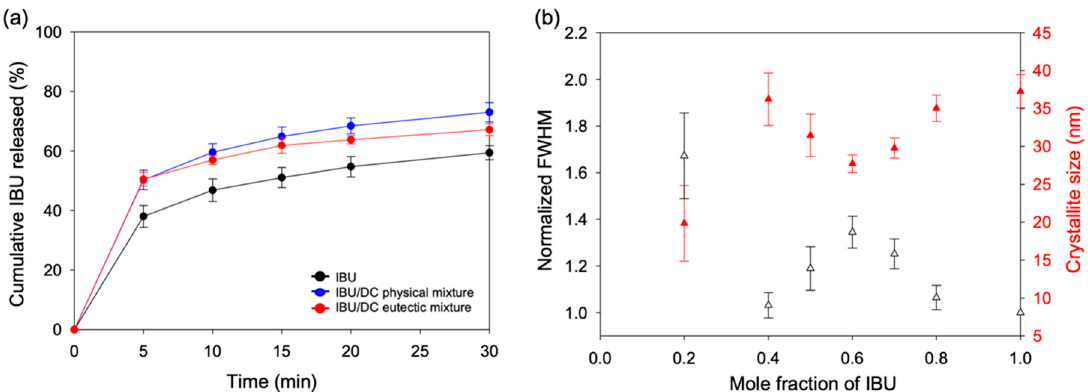
Figure 5. ( a ) Dissolution profiles (FeSSIF, n = 3) of the IBU/DC eutectic mixture (6:4) in comparison of physical mixture and neat IBU. ( b ) Microstructure analysis using peak broadening of X-ray diffraction peaks. Crystallite size was calculated using (2 0 0), (2 1 0), and (2 1 − 1) di ff raction peaks with the use of Scherrer equation, and the FWHM was shown as normalized against the narrowest peaks (neat